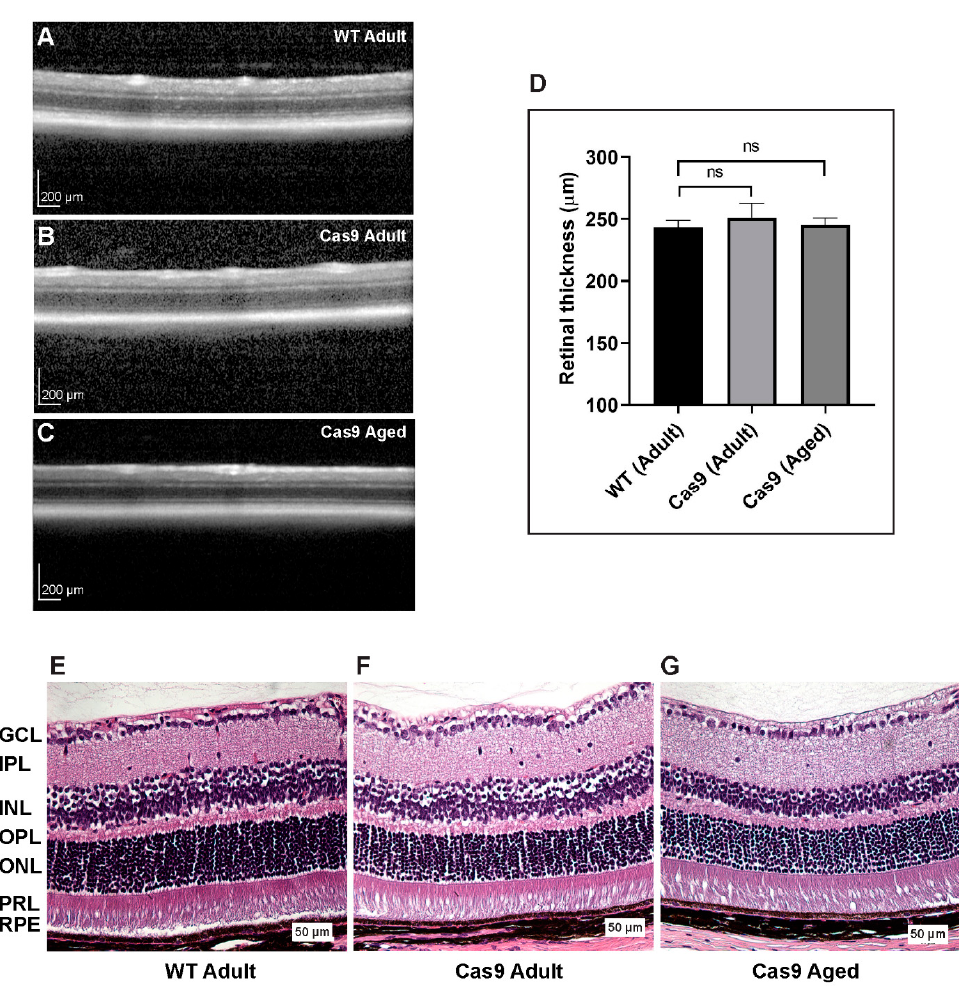
Figure 3. Comparison of WT and Cas9 mice retinal structure using SD-OCT imaging and histostain- ing. ( A – C ) Representative SD-OCT images from WT and Cas9 mice reveal normal retinal layers with no indication of retinal thinning or degeneration. ( D ) No statistically significant differences were observed in total retinal thickness between WT and Cas9 mice ( p = 0.53, ns, no significance,